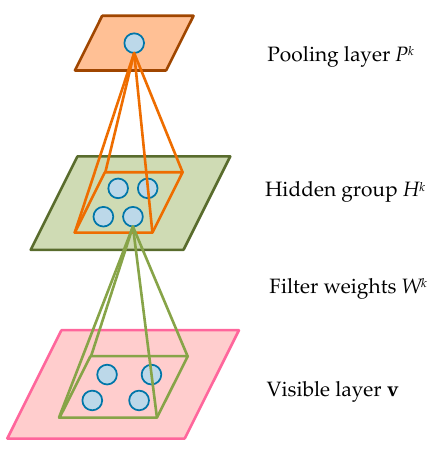
Figure 1. Typical structure of the convolutional restricted Boltzmann machine (CRBM) model.